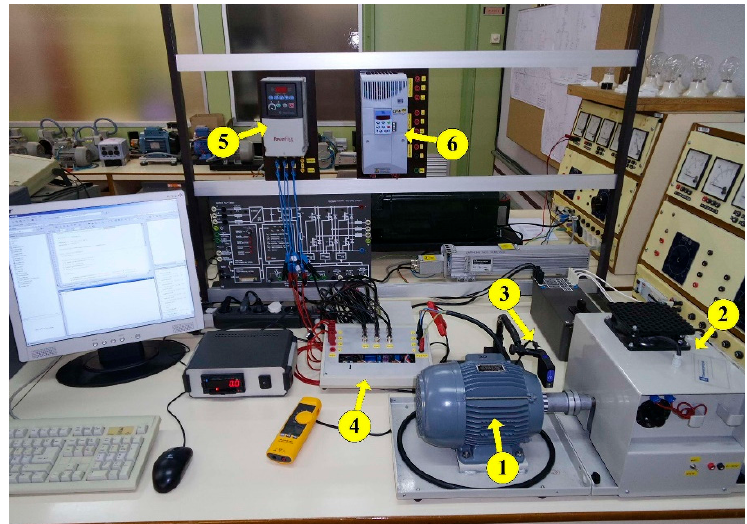
Figure 3. Experimental workbench: (1) Induction motor, (2) magnetic brake, (3) Optical sensor, (4) Data acquisition board, (5) Allen Bradley, and (6) WEG inverters. Table 1. SKF Explorer 6004 Bearing specifications.